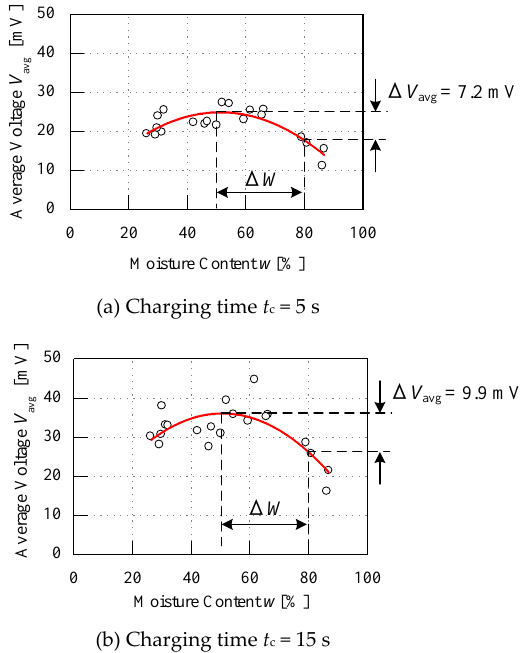
Figure 9. Graph of different charging time.